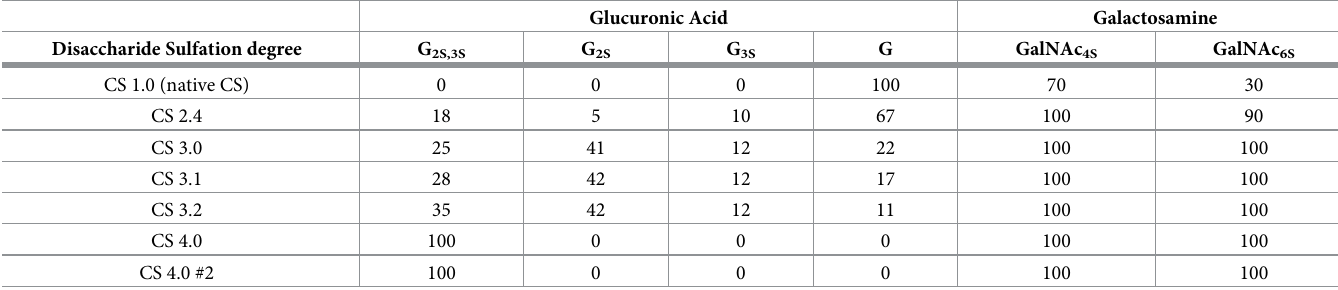
Table 1. Sulfation pattern (%) of different preparations of OSCS.